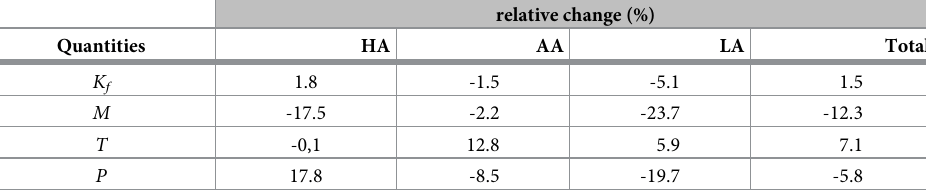
Table 4. Relative changes in % for the quantities involved in the KA model between both contexts.